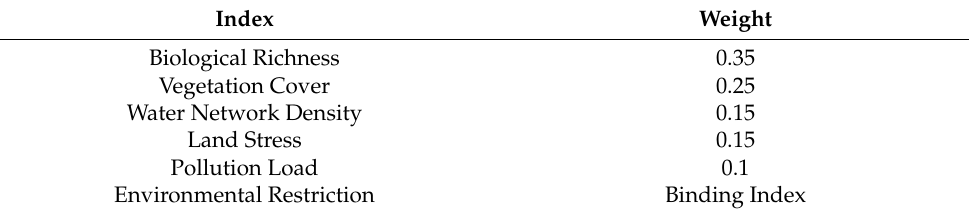
Table 2. The weight of each indicator of the ecological environment evaluation